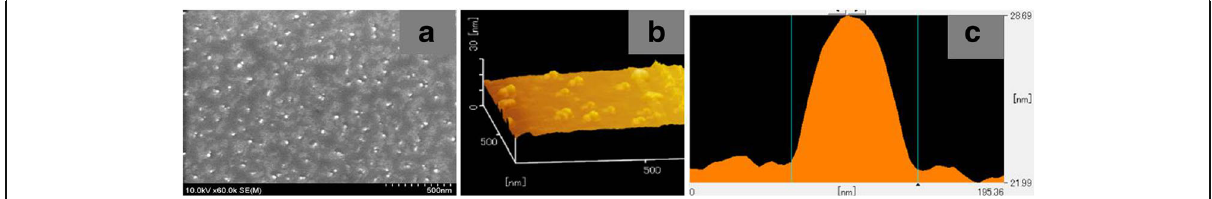
Fig. 2 FESEM ( a ) and AFM ( b ) images of the pre-deposited Al on Si substrate. c A parameter measurement of one Al droplet by